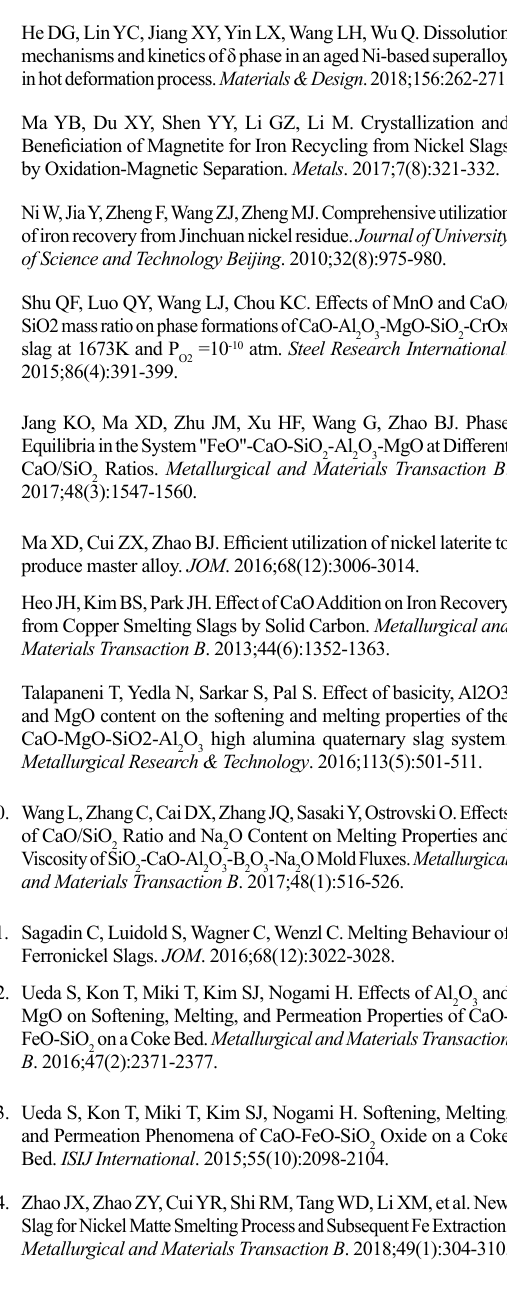
Figure S1Effects of w (CaO) on the phase fractions of samples with F/S=1.33 at equilibrium state. Figure S2Effects of w (CaO) on the phase fractions of samples with F/S=1.73 at equilibrium state. Figure S3Effects of w (CaO) on the phase fractions of samples with M/S=0.40 at equilibrium state. Figure S4Effects of w (CaO) on the phase fractions of samples with M/S=0.60 at equilibrium